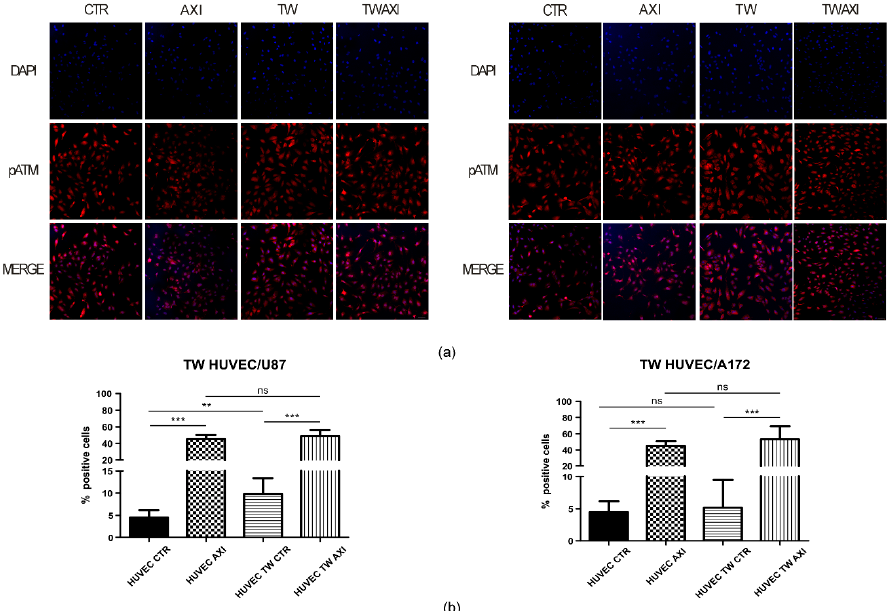
Figure 4. Axitinib-dependent ATM phosphorylation in HUVECs was not altered by GBM cells coculture. pATM immunostaining was performed on HUVECs cocultured with U87 ( a , b , left panel) or A172 ( a , b , right panel) GBM cells. CTR: sham-treated HUVECs; AXI: Axitinib-treated HUVECs; TW: sham-treated HUVECs cocultured in transwell with GBM cells for 48 h; TW AXI: HUVECs cocultured in transwell with GBM cells and treated with Axitinib. Immunofluorescence was performed at the end of the 1h Axitinib pulse. Mean values and standard deviation were generated from at least three biological replicates. Magnification: 20 × ; scale bar 50 µ